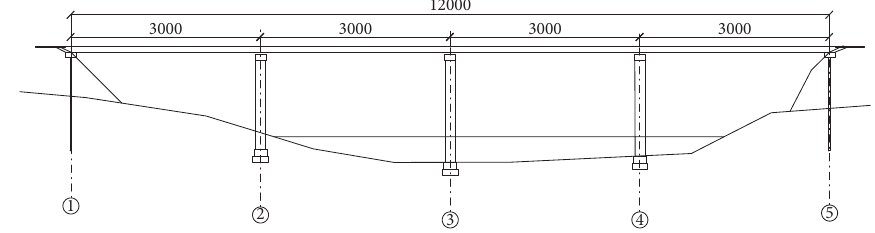
Figure 1: Elevation of Shangban Bridge. (dimensions in cm).